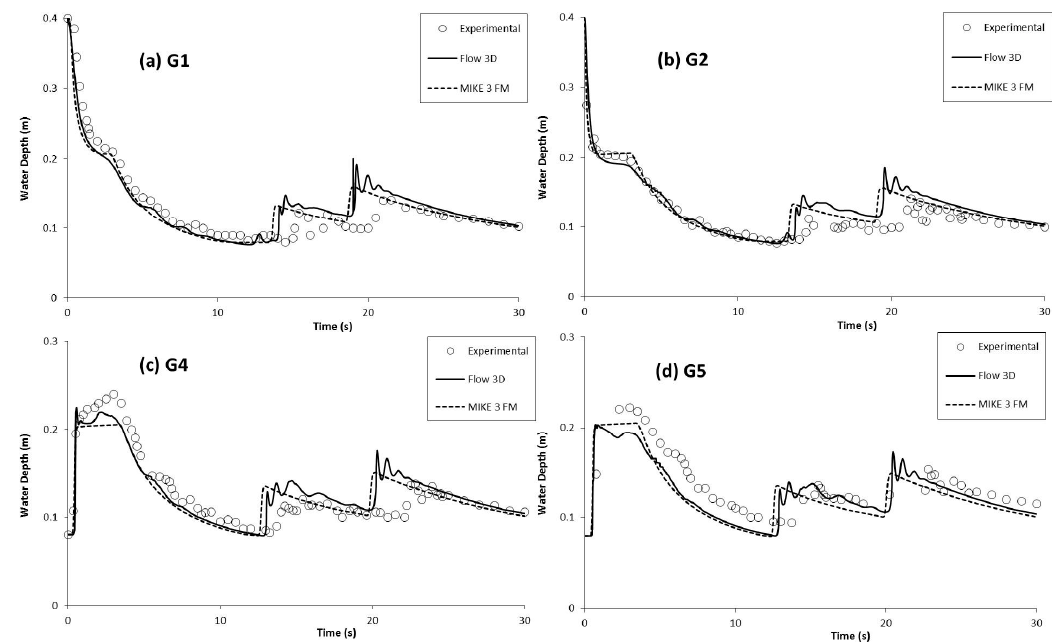
Figure 11. Measured and computed water level hydrographs at various positions for the wet-bed by Khankandi et al. [39]: ( a ) G1 ( − 0.5 m); ( b ) G2 ( − 0.1 m); ( c ) G4 (0.8 m); and ( d ) G5 (1.0 m). Table 3. RMSE values for the water depth variations observed by Khankandi et al. [39] at the late stage. Water Depth Probe Ratios